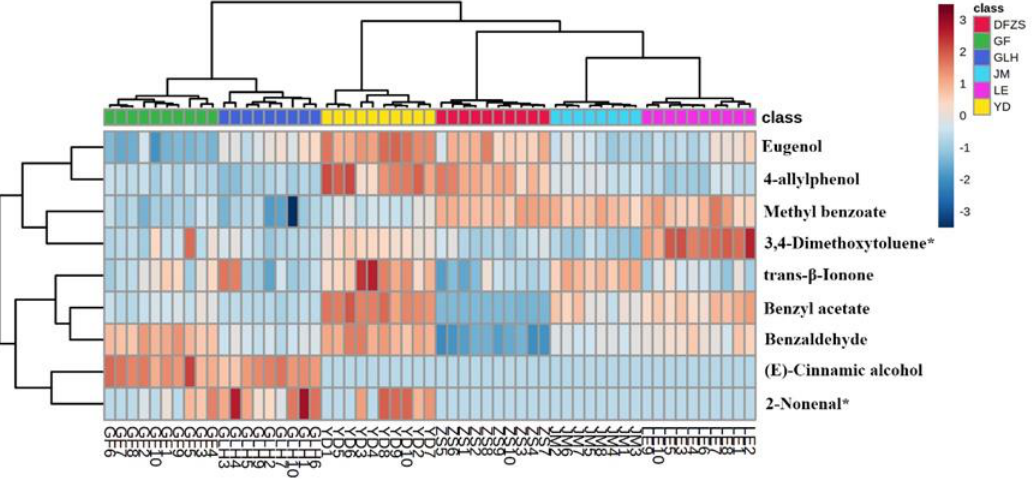
Figure 5. HCA analyses of nine differential aroma compounds of six varieties of P. mume blossom samples. “*” indicates that the compound may be other isomers.